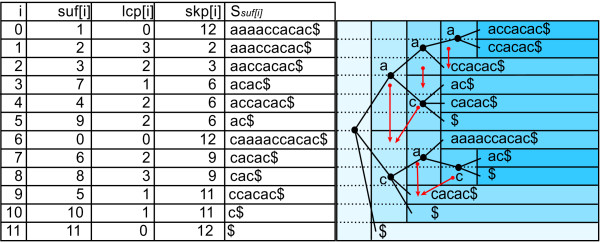
Relationship between enhanced suffix array and suffix tree. The enhanced suffix array consisting of tables suf, lcp, skp (left) and the suffix tree (right) for sequence S = caaaaccacac. Some skp entries are shown in the tree as red arrows: If skp[i] = j, then an arrow points from row i to row j. For clarity, suffixes corresponding to suf[i] are given in table Ssuf[i].